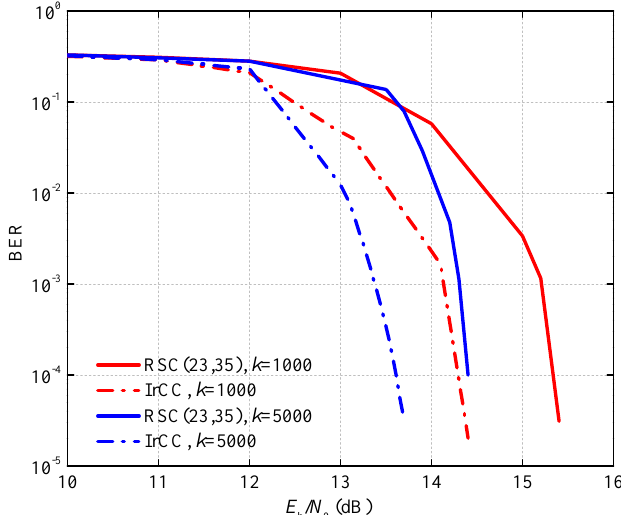
Figure 6. BER performance comparison of RSC and IrCC under the Rayleigh fading channel, R = 0.5.